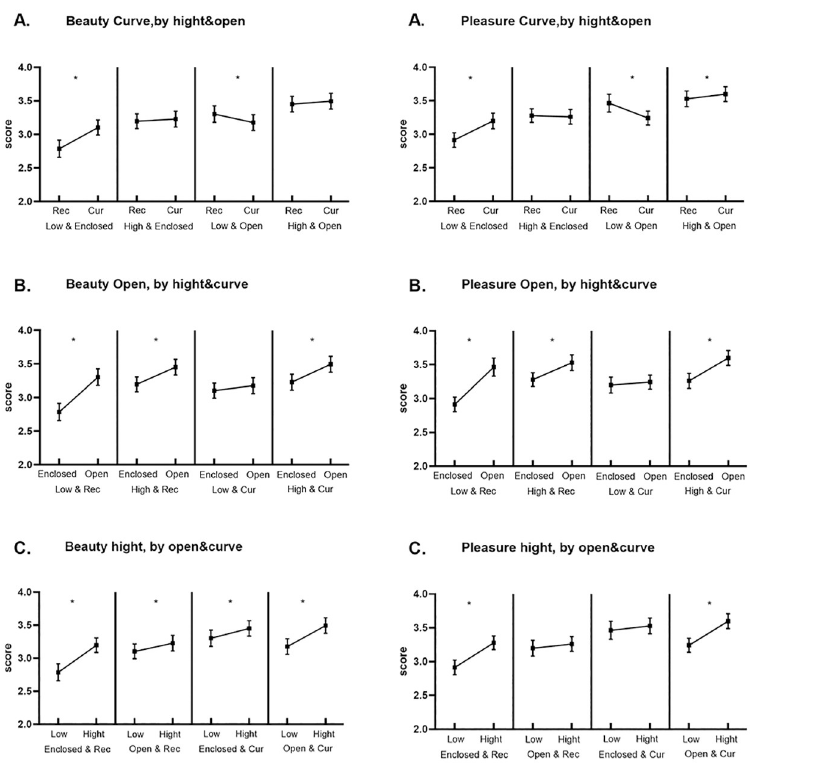
Fig 4. Comparison between beauty and pleasantness ratings in different conditions.